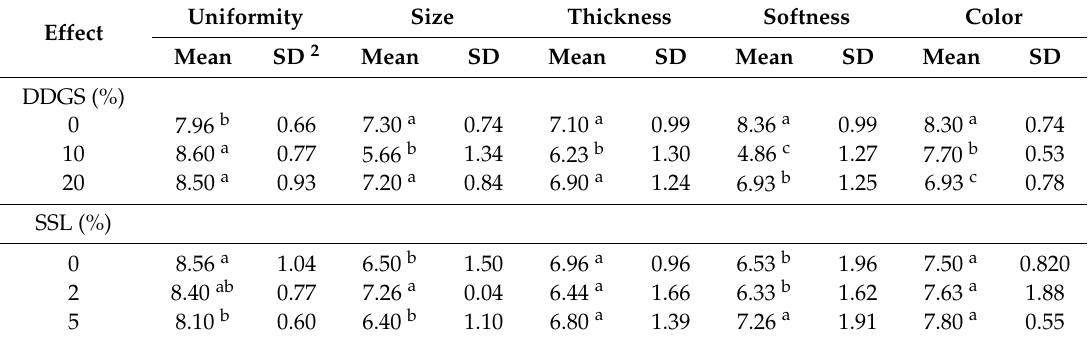
Table 11. Main effects on quality evaluation parameters 1 .